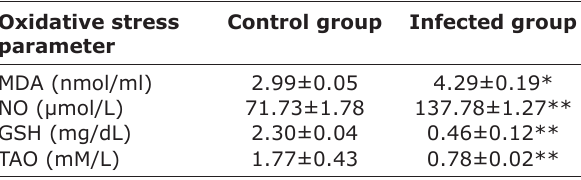
Figure-1: The macroscopic examination detected the liver fluke in the liver of cattle carcasses. (a and b) the number of the adult parasites and the presence of cirrhosis, cholangitis, cholangitis purulenta, cirrhosis hepatitis in the postmortem